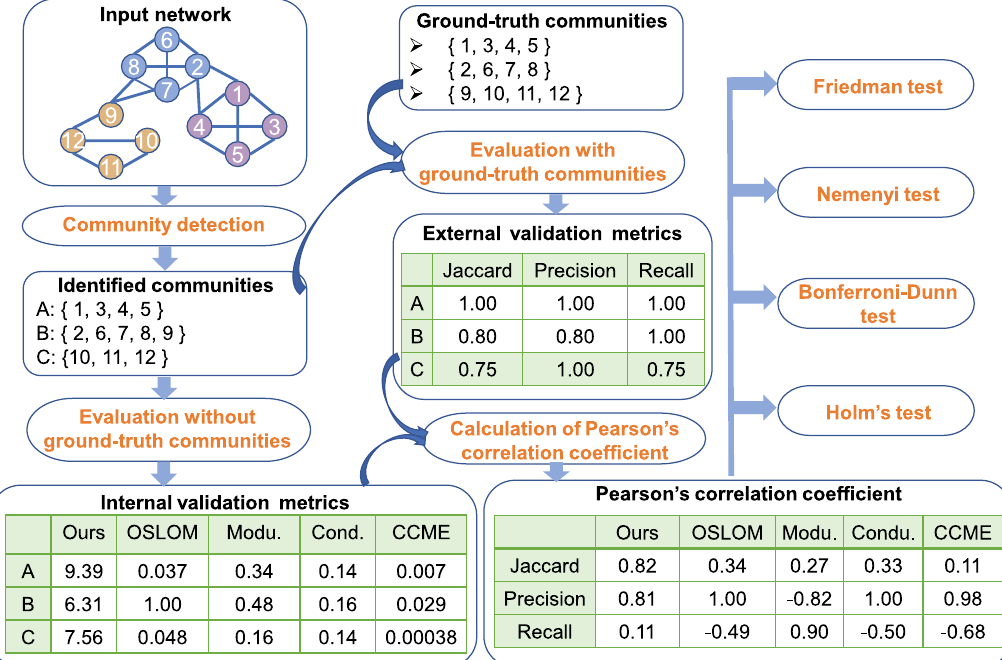
Figure 2. The main workflow of our experiments. Given a network with three ground-truth communities: {1, 3, 4, 5}, {2, 6, 7, 8} and {9, 10, 11, 12}, three communities are detected by the SLPAw algorithm: A = { 1, 3, 4, 5 } , B = { 2, 6, 7, 8, 9 } , C = { 10, 11, 12 } . Each identified community can be assessed using both the internal